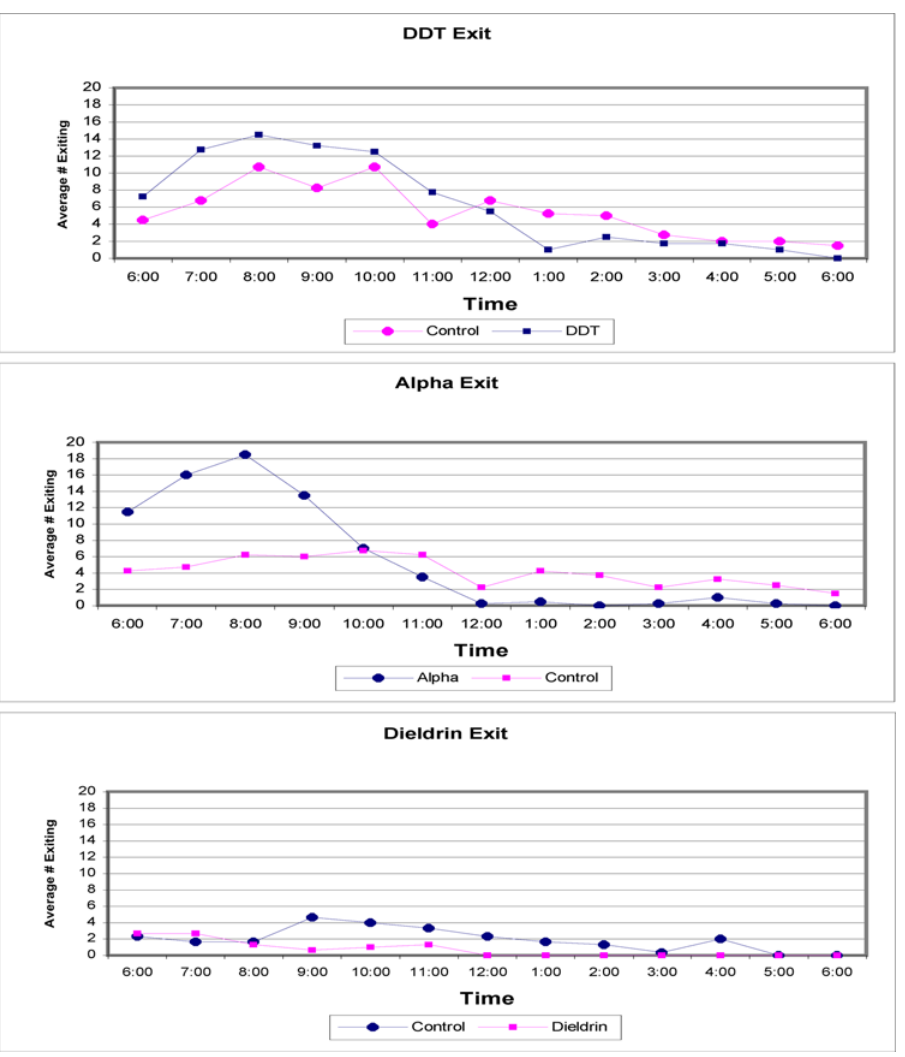
Figure 4. Exiting Ae.aegyptiby time for treated and matched control huts using DDT, alphacypermethrin and dieldrin.